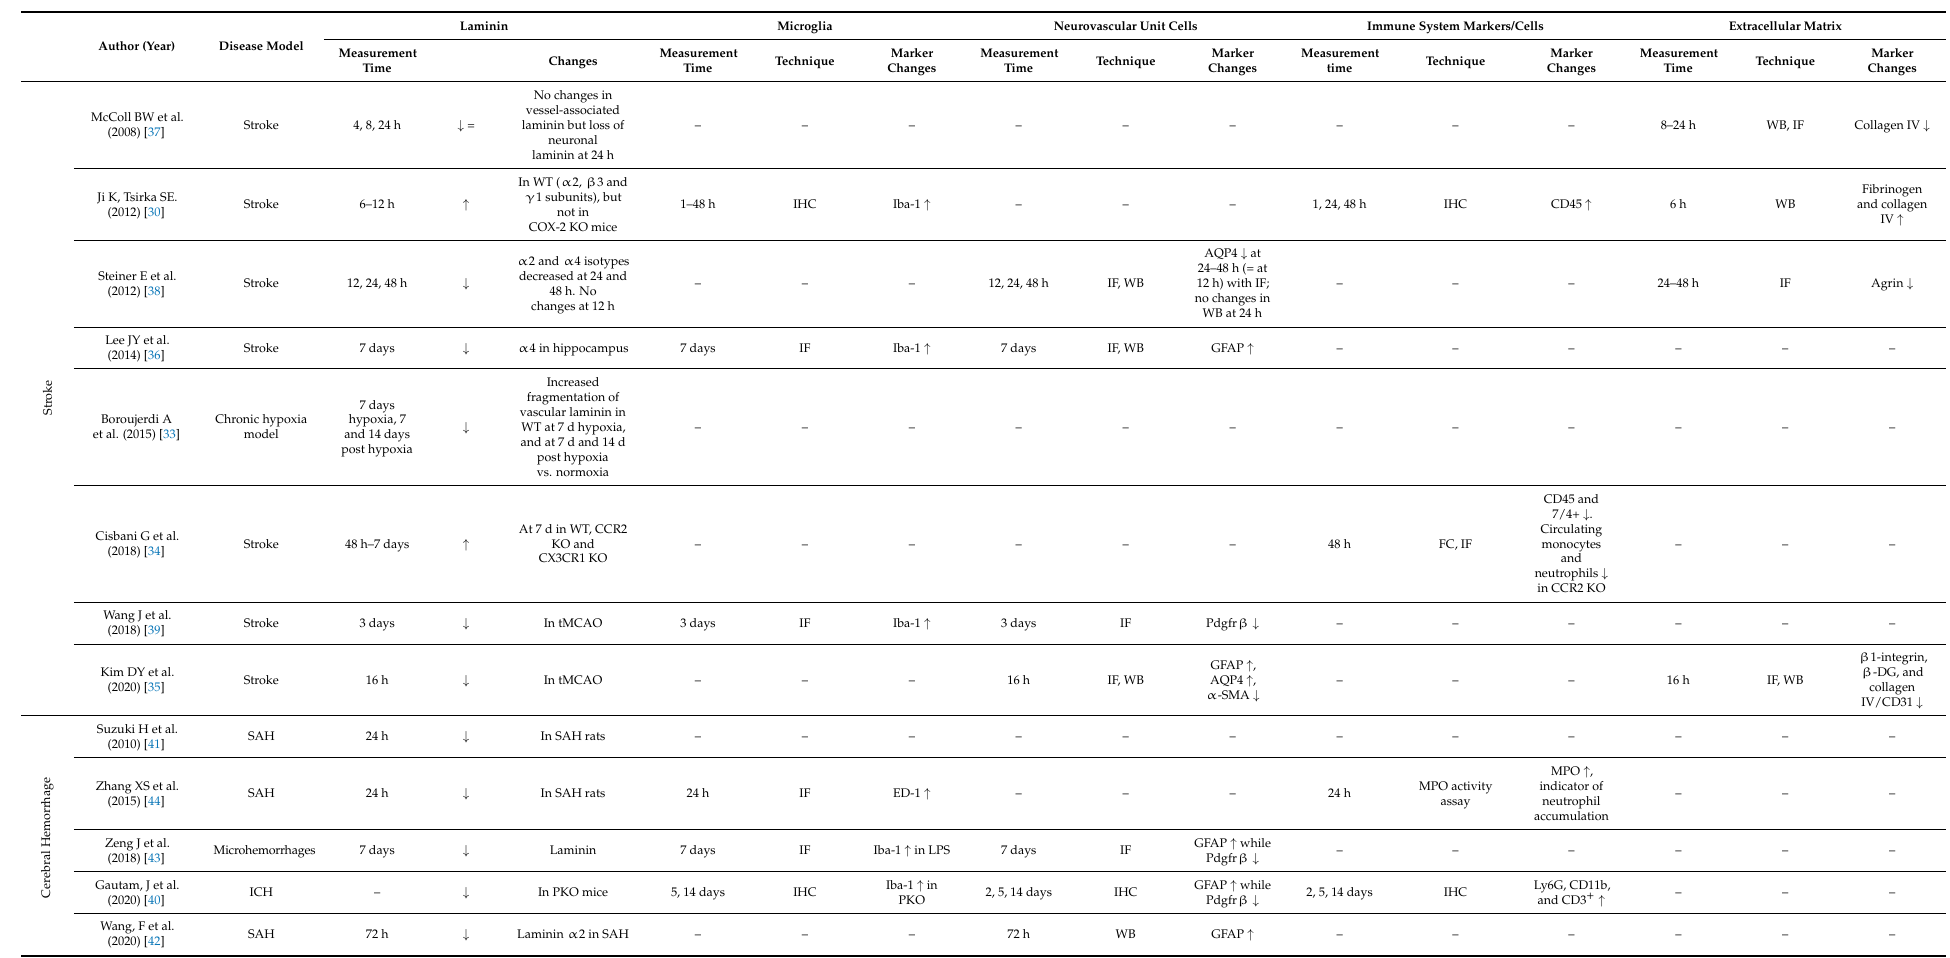
Table 5. Changes in cells and in